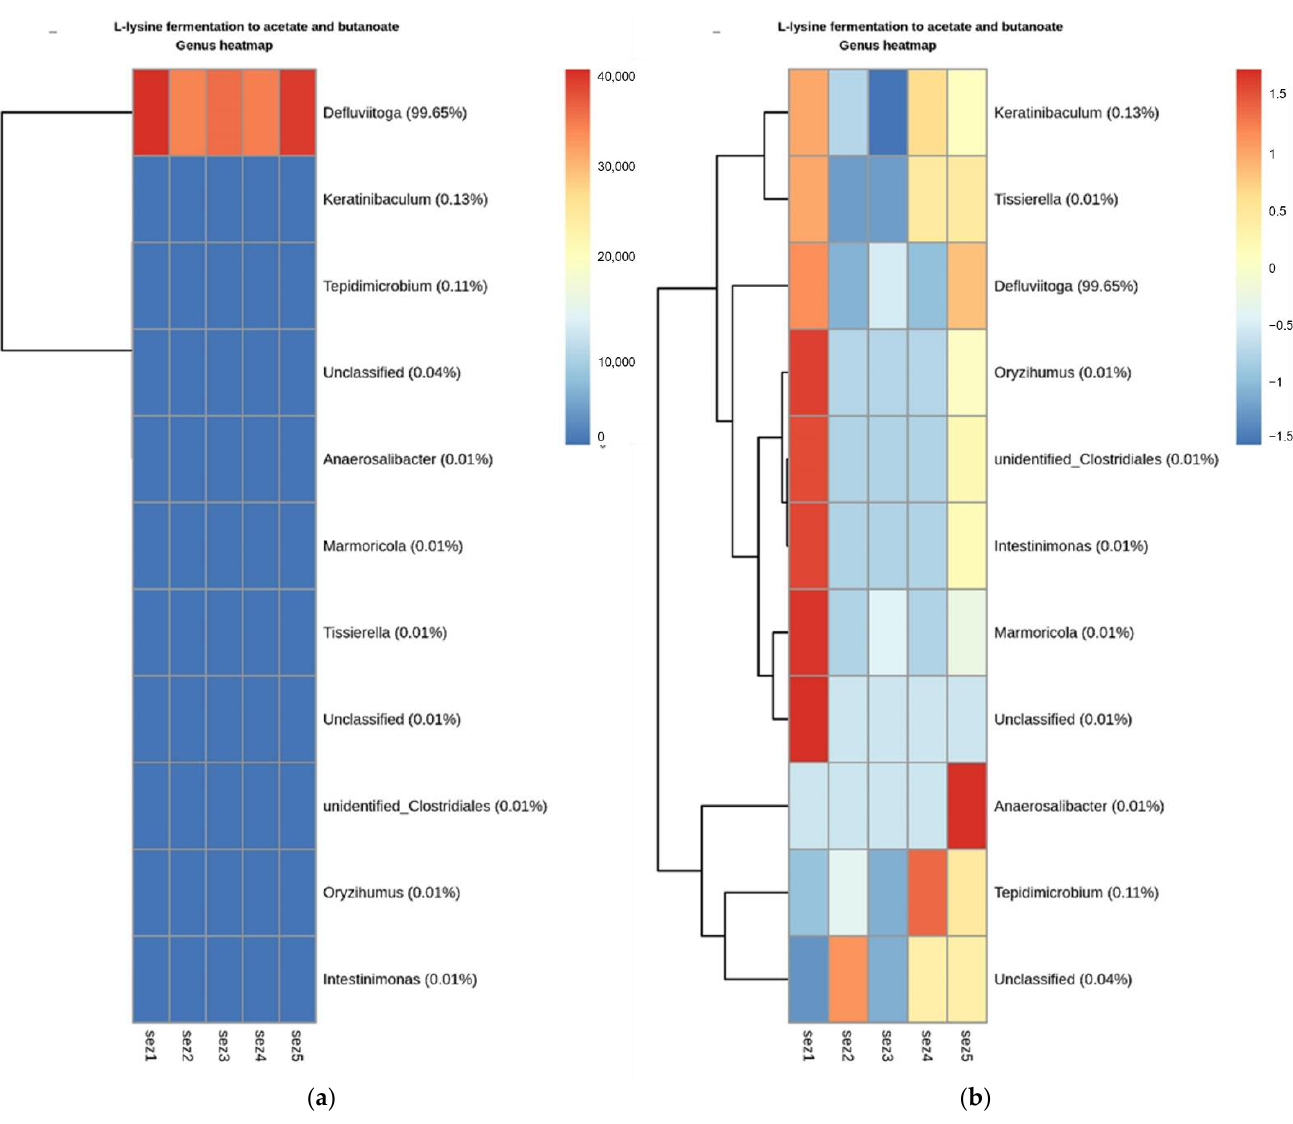
Figure A2. Functional heatmaps of L-lysine fermentation to acetate and butanoate: ( a ) absolute counts and ( b ) autoscaled counts, aggregated at the genus level.